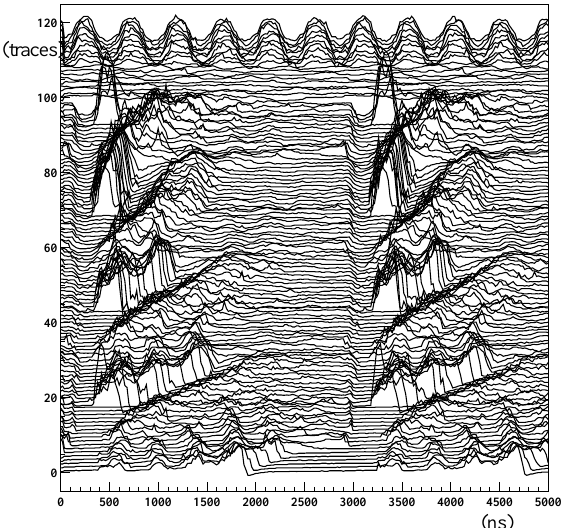
FIG. 10. Mountain-range plot of the wall-current monitor. The interval of their traces is 5.8 ms. The horizontal axis is the rf phase. The period of one revolution is 2850 ns.